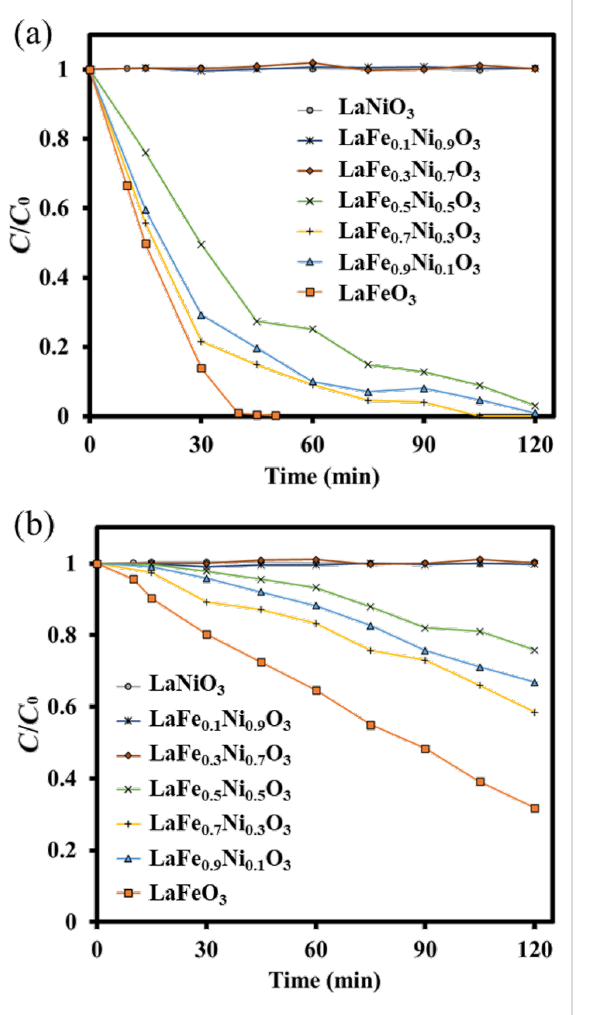
Figure 8: MB degradation experiments using various LaFe x Ni 1 − x O 3 with different Fe/Ni ratios prepared at (a) pH 0; (b) pH 7. ic surface, which improved the separation of photogenerated charge carriers and the efficiency of the surface reaction. For comparison, the second-order kinetics analysis was also con-